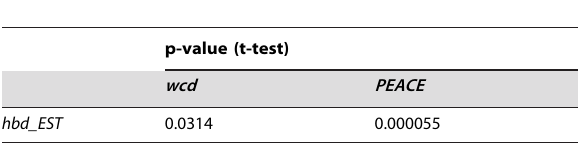
Table 5. The p-values of the t-test.